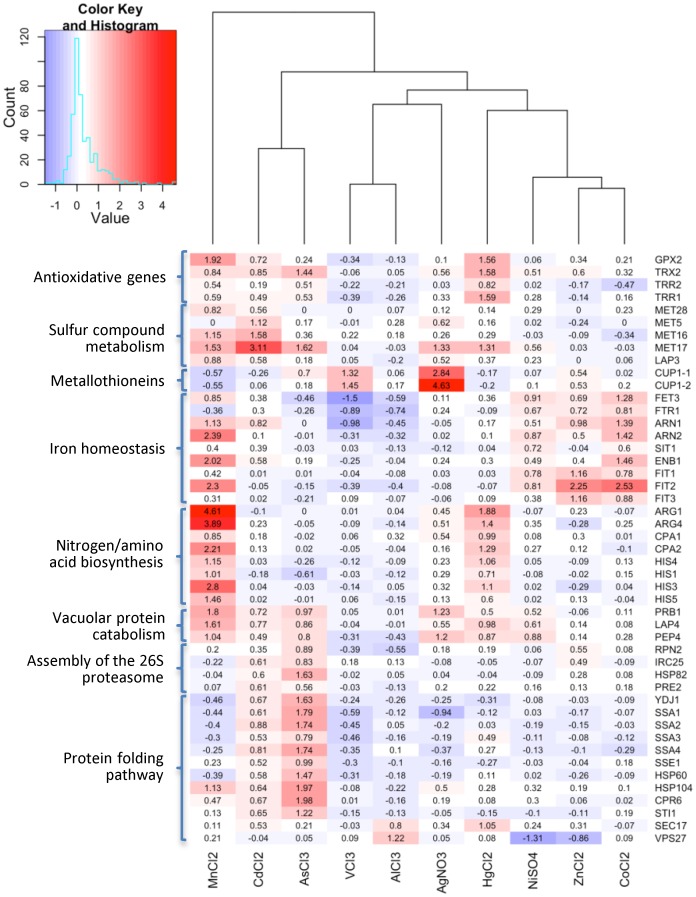
Transcriptional metal defense responses of S. cerevisiae to acute metal stress.Two-dimensional hierarchical cluster heat map of the transcriptional profile of genes responding to at least 2 metal stress conditions and being associated to significant GO-Terms; the displayed intensities are the log2 ratios. Differences with expression levels greater than the mean are colored in red and those below the mean are colored in blue. The histogram summarizes the distribution of the fold-changes of all combinations (47 genes and 10 conditions).